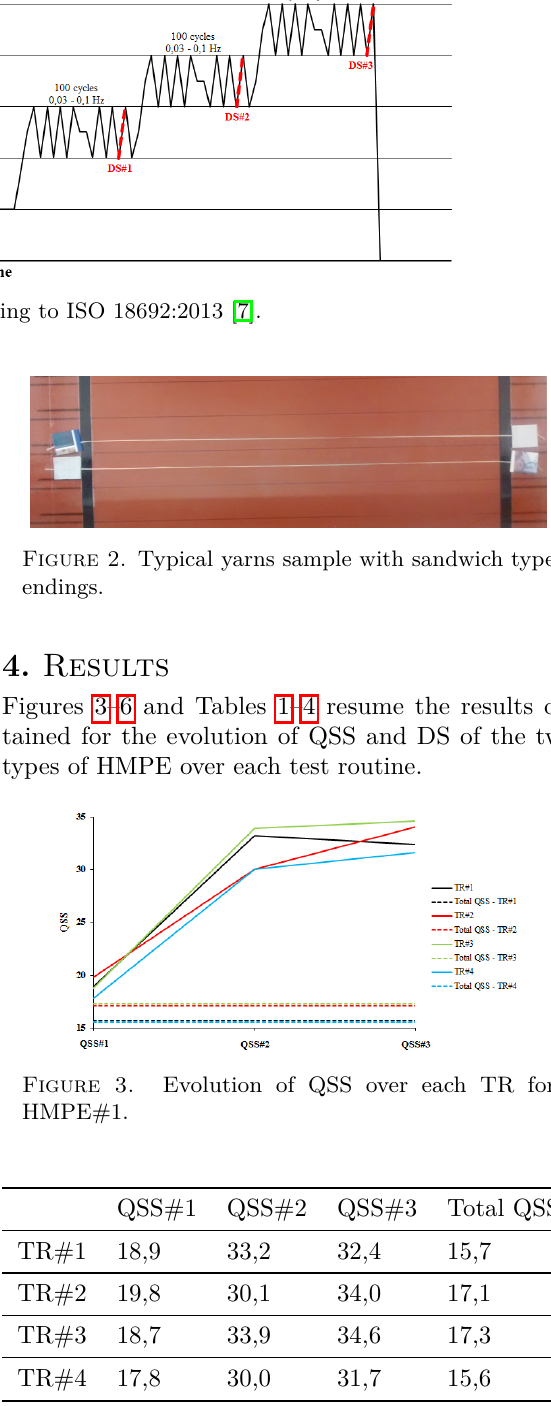
Table 1. Results for QSS: